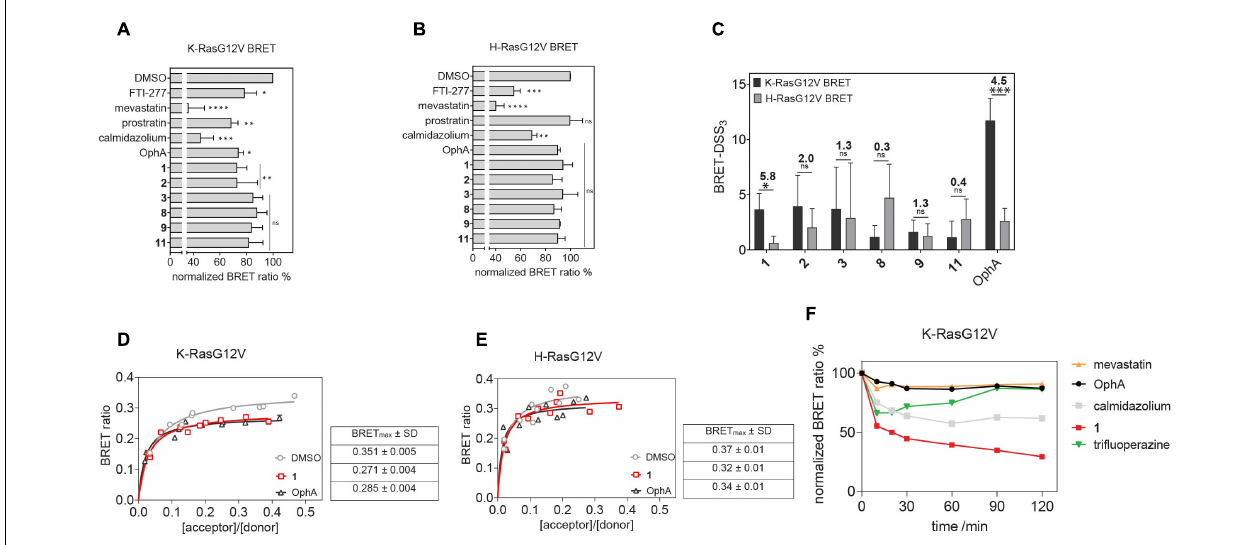
FIGURE 3 | Nanoclustering-BRET assays confirm K-Ras selectivity and fast intracellular activity of compound 1 in cells. (A,B) Testing of top six benzazulenones at 20 µ M and 24-h exposure in K-RasG12V (A) and H-RasG12V (B) nanoclustering-BRET assays. Controls are FTI-277 (1 µ M), OphA (2.5 µ M), mevastatin (10 µ M), calmidazolium (20 µ M), and prostratin (10 µ M). The acceptor/donor (A/D) plasmid ratio of GFP2- and Rluc8-tagged RasG12V was 4/1. Data represent mean values ± SD, n = 3. (C) BRET-DSS 3 values for selected six benzazulenones and OphA, derived from dose response analysis of benzazulenones (0.1–80 µ M) and OphA (0.3–20 µ M) on K-RasG12V and H-RasG12V nanoclustering-BRET data ( Supplementary Figures 3A,B ). Numbers above the bars indicate the K-RasG12V/H-RasG12V BRET-DSS 3 ratios. The A/D plasmid ratio was 4/1. Data represent mean values ± SD, n ≥ 3. (D) K-RasG12V and (E) H-RasG12V nanoclustering-BRET donor saturation titration curves showing the effect of OphA (2.5 µ M), 1 (20 µ M), and vehicle control. Data represent mean values ± SD, n = 2. Note that error bars are very small and may not be recognizable. BRET max data represent mean values ± SD, n = 2. (F) Time-dependent change of K-RasG12V nanoclustering-BRET signal after treatment with 1 (50 µ M), OphA (10 µ M), mevastatin (10 µ M), trifluoperazine (20 µ M), and calmidazolium (20 µ M). The A/D plasmid ratio was 4/1. Data represent mean values ± SD, n ≥ 2. The statistical significance levels are annotated as * p < 0.05; ** p < 0.01; *** p < 0.001; **** p < 0.0001, or ns, not